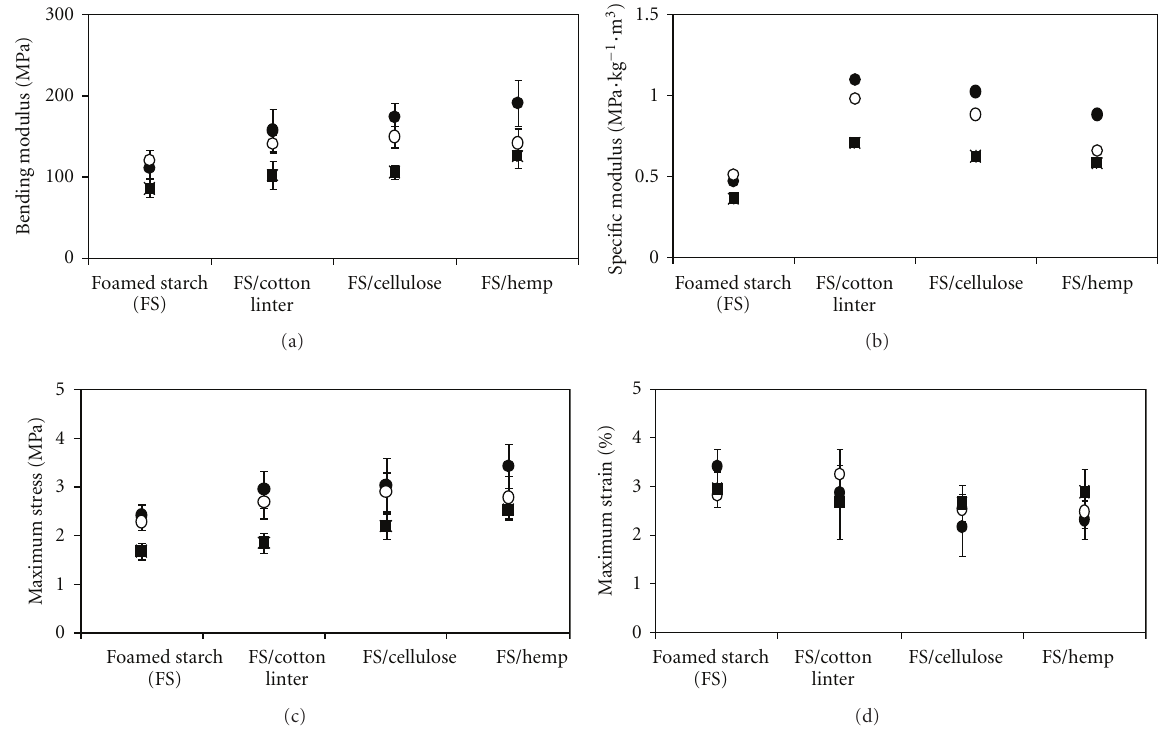
Figure 2: Mechanical properties of starch foam and 10wt% reinforced biocomposites foams as a function of the fibre nature and the relative humidity: (cid:2) 33 RH%, (cid:3) 56 RH%, (cid:2) 75 RH%, (a) bending modulus, (b) bending modulus/density ratio, (c) maximum stress, (d) maximum strain. Table 6: Densities and expansion ratios of starch-based biocomposites foams compared to starch foam. Material Content (wt%) Density (g/cm 3 ) Starch foam